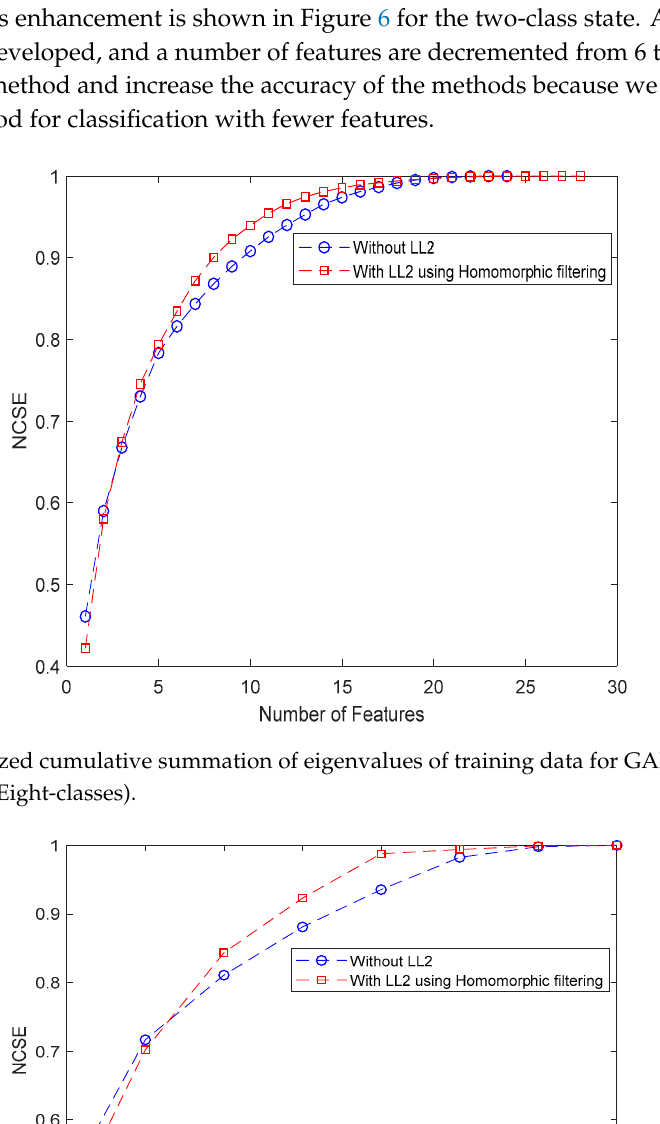
Figure 7. Normalized cumulative summation of eigenvalues of training data for the GARCH and LLA methods for different PCA and PCA + LDA methods (eight-classes). Figure 8. Normalized cumulative summation of eigenvalues of training data for the GARCH and LLA methods for different PCA and PCA + LDA methods (two-classes). NC SE